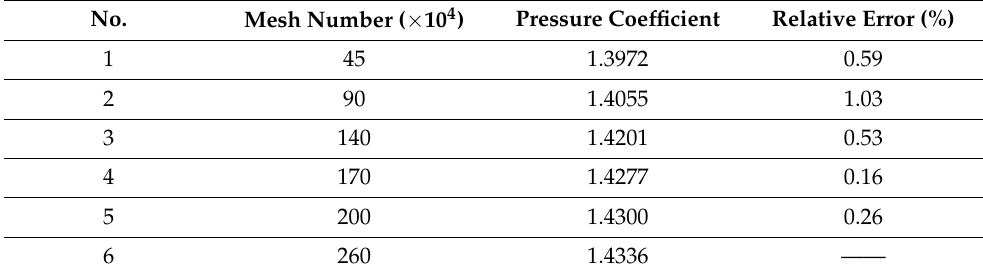
Figure 2. Mesh of the bend pipe with different bending angles. Table 1. Mesh independence